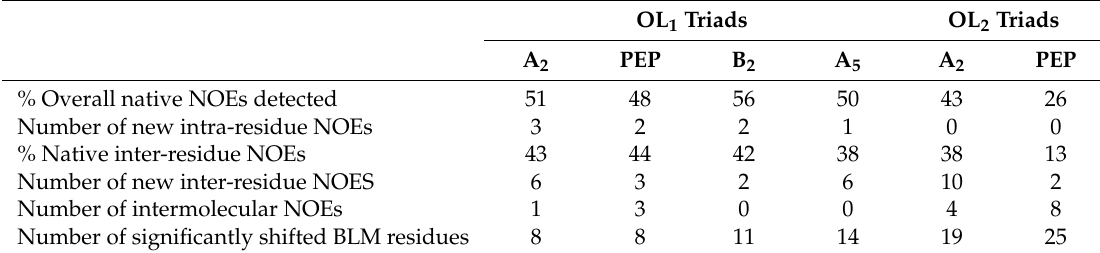
Table 2. Comparison of the overall changes in significant signal shifts and native and new NOEs displayed by the Zn(II)BLMs after binding to the indicated